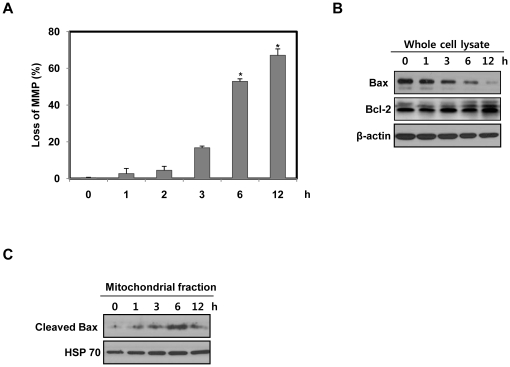
β-lap causes Bax cleavage and translocation of cleaved Bax to mitochondria.(A) NQO1+-MDA-MB-231 cells were treated with 5 µM of β-lap for the indicated times. After 12 h, cells were loaded with 30 nM of DiOC6(3) for a further 30 min of the treatments. After removal of medium, the concentration of retained DiOC6(3) was measured by flow cytometry. Results from three independent experiments are expressed as means ± SEMs. *Significant difference between control and β-lap-treated cells at p<0.05. (B) NQO1+-MDA-MB-231 cells were treated with 5 µM of β-lap for the indicated times. Cell lysates were subjected to Western blot analysis using anti-Bax, -Bcl-2 and -β-actin antibodies. β-actin was used as a loading control. The data represent a typical experiment conducted three times with similar results. (C) NQO1+-MDA-MB-231 cells were treated with 5 µM of β-lap for the indicated times. Mitochondrial fractions were prepared and subjected to Western blot analysis using anti-Bax and -mitochondrial HSP70 antibodies. Mitochondrial HSP70 was used as a mitochondrial marker protein. The data are representative a typical experiment conducted three times.